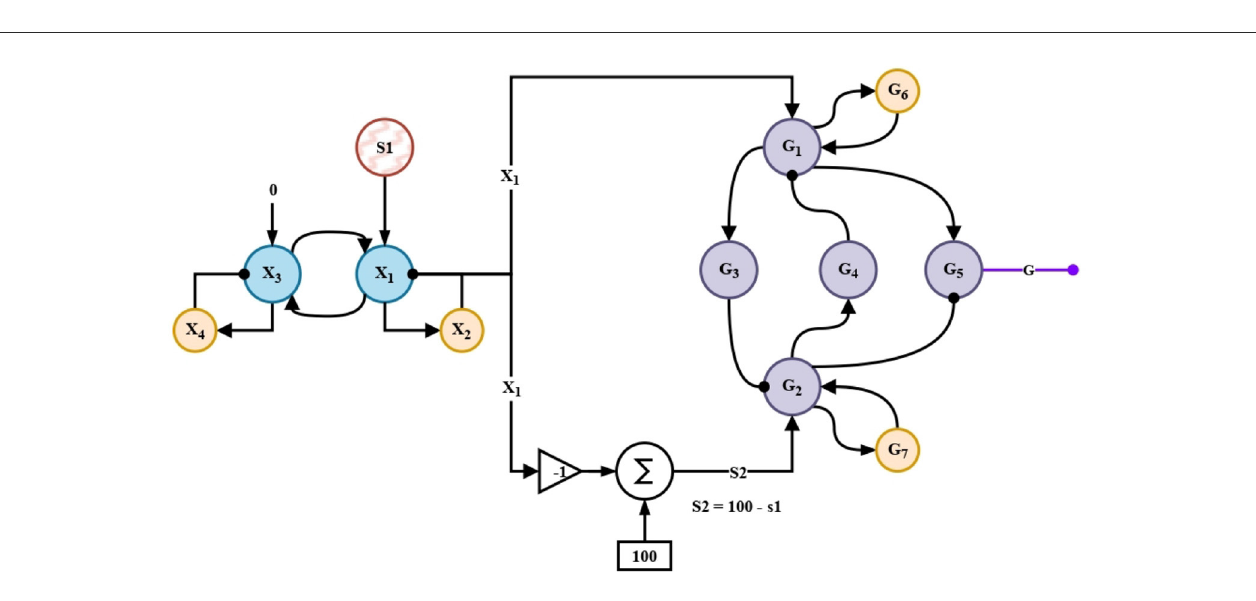
FIGURE7 Meta-control